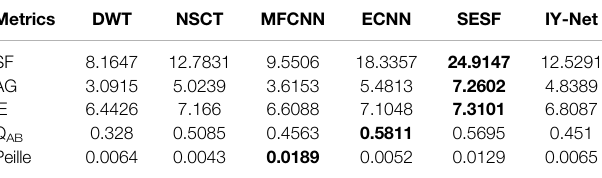
Bold indicates best